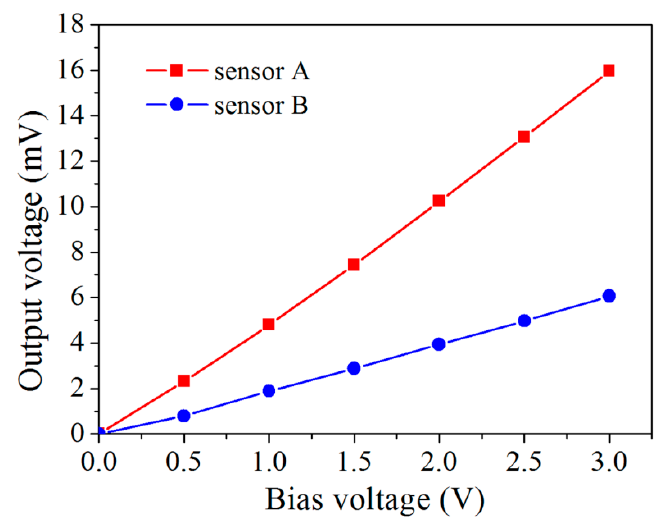
Figure 10. Zero-point deviation of the output voltage at different bias voltages.